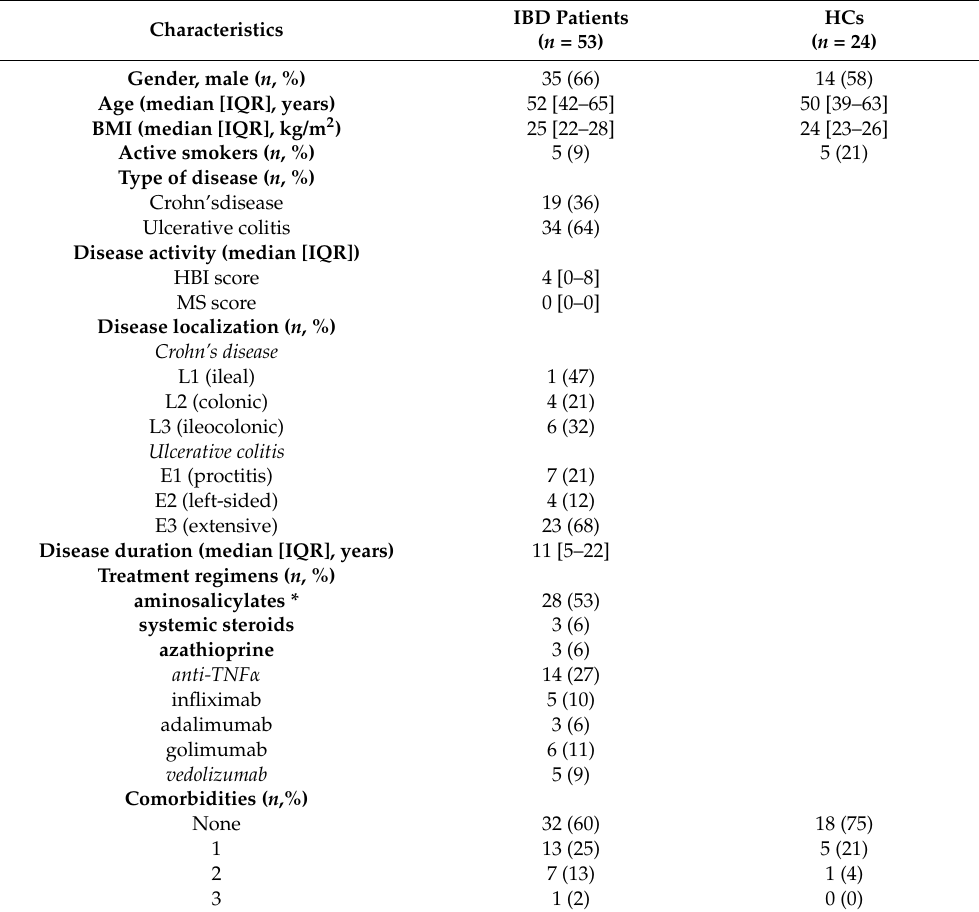
Table 1. Demographic and clinical characteristics of the study cohort.